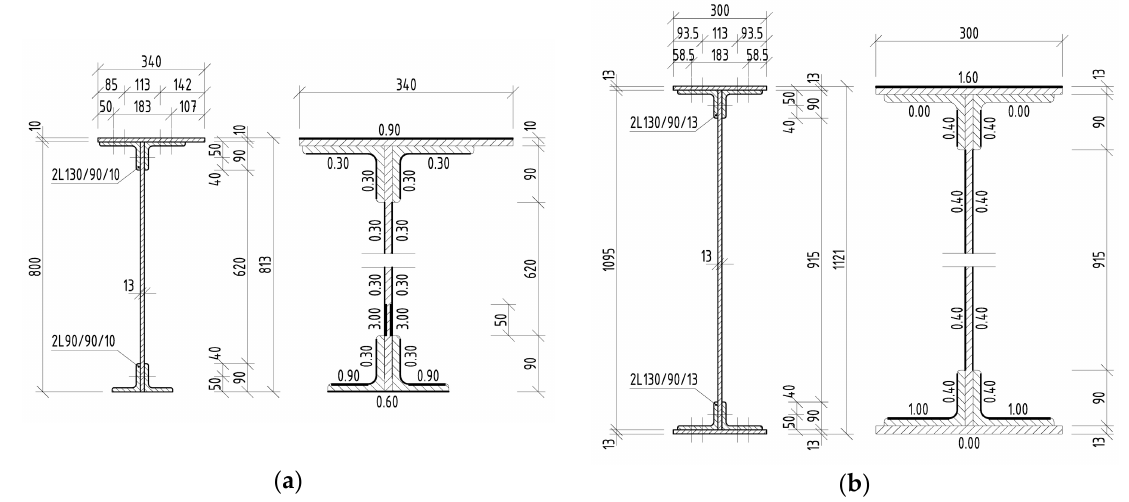
Figure 6. Riveted I-sections and average corrosion losses of deck elements in the case of Bridge 3: ( a ) first stringer; ( b ) crossbeam.